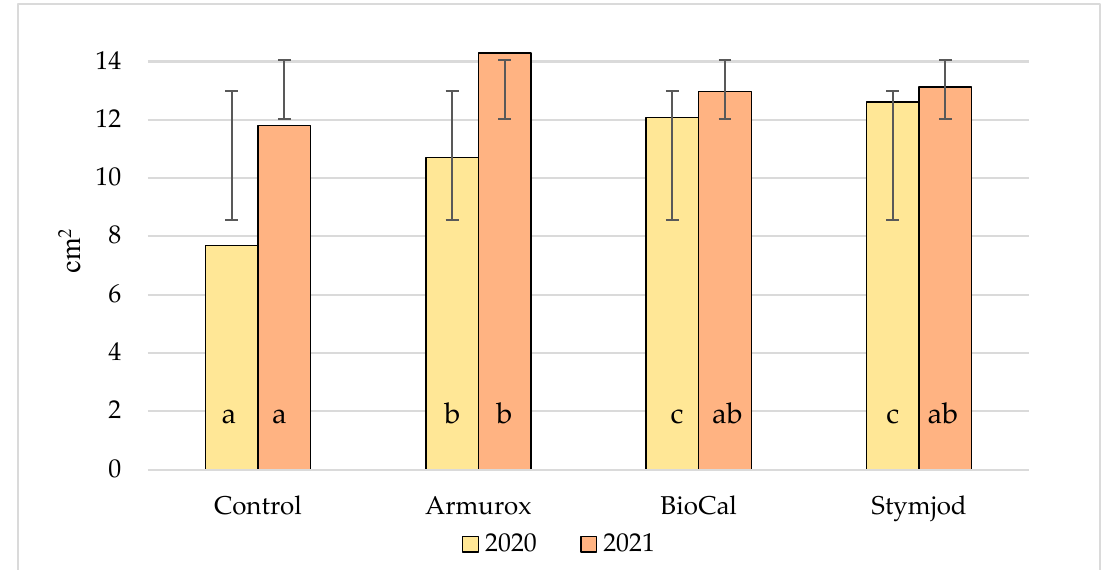
Figure 1. Effect of foliar fertilization on leaf blade area (cm 2 ) of highbush blueberry in 2020 and 2021. The mean values marked with the same letters do not differ significantly at a = 0.05.